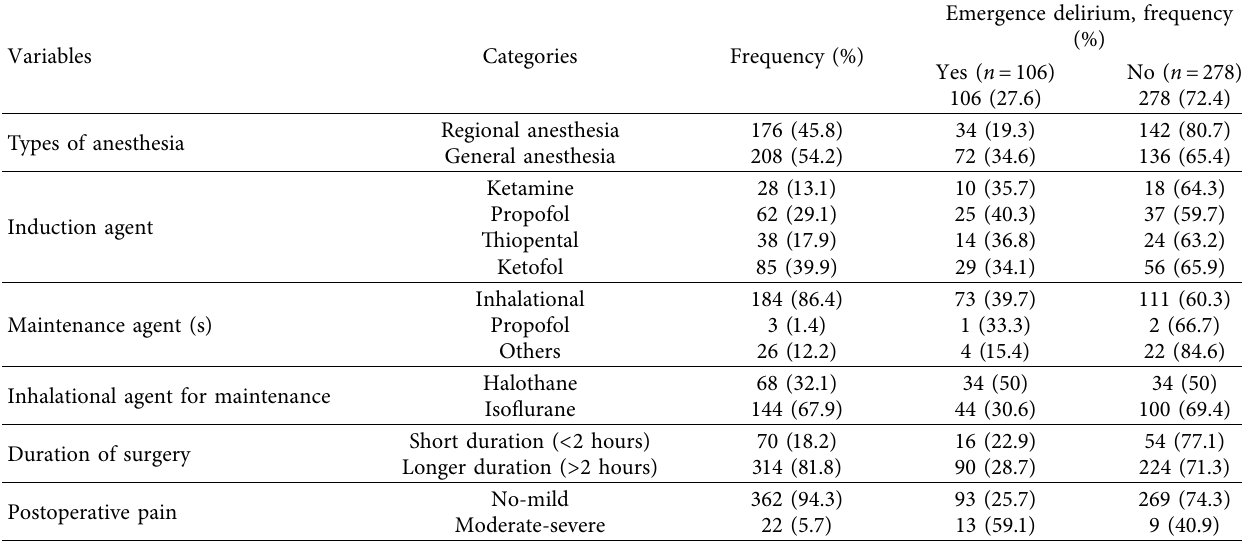
Table 2: A cross-tabulation of the intraoperative and postoperative factors in older patients who underwent elective surgery at Teaching Hospitals of Ethiopia, Ethiopia ( n �